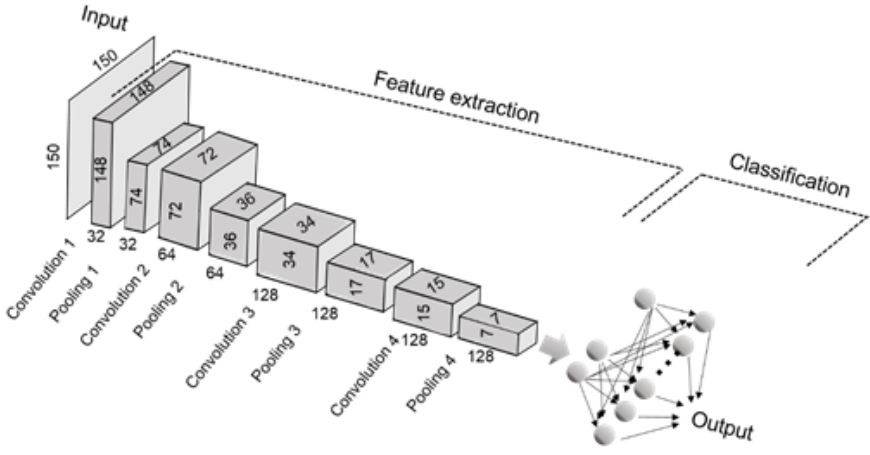
Figure 4. A schematic of a CNN architecture (manual model 1) used in Section